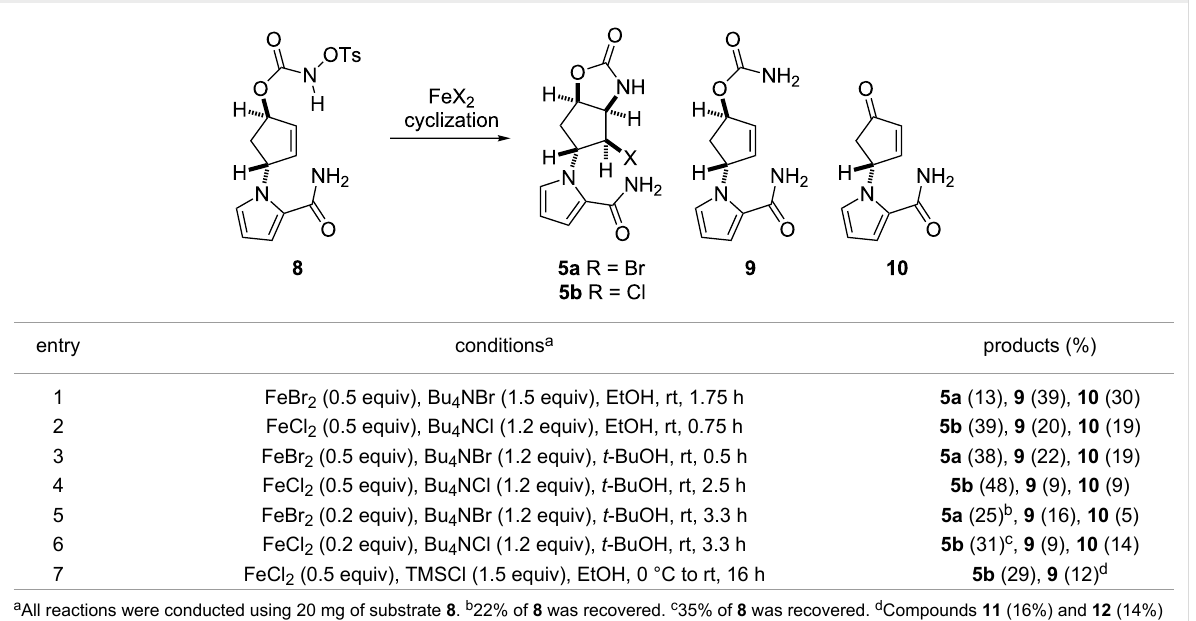
Table 1: Aminohalogenation of N -tosyloxycarbamate 8 by iron(II) catalysis.